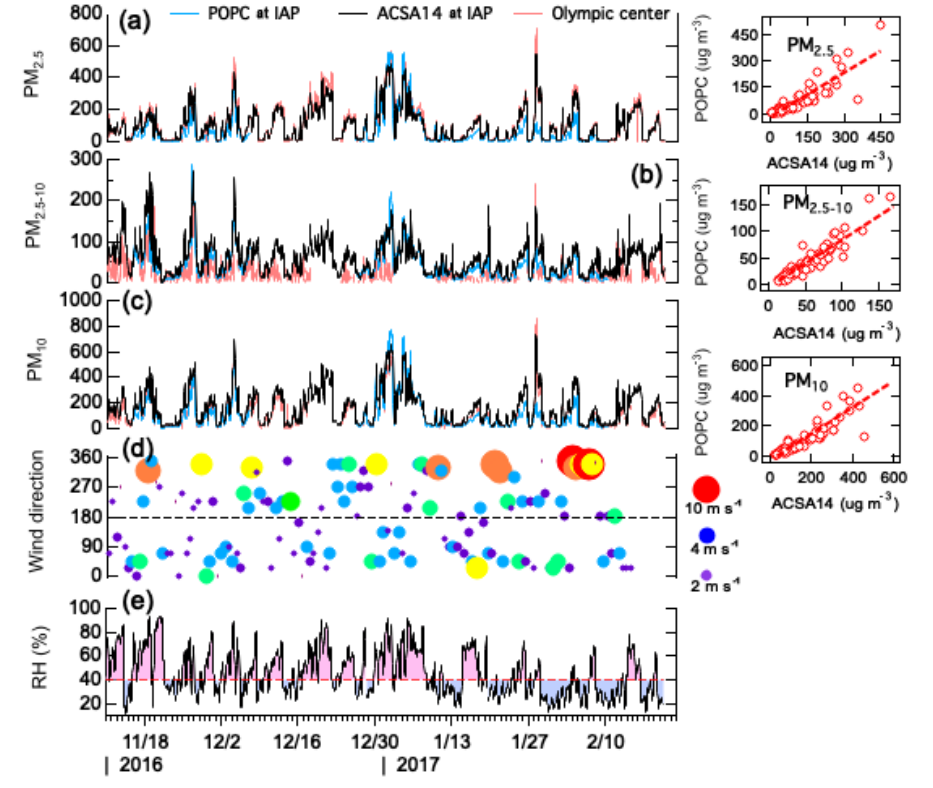
Figure 2. Temporal variations in mass concentration of PM 2 . 5 (a) , PM 2 . 5 − 10 (b) and PM 10 (c) measured by ACSA-14 and derived from POPC measurements, wind speed and direction (d) and relative humidity (RH) (e) at the observation site. The three scatter plots on the right indicate the linear relationship between ACSA14 and POPC, the correlations are Y POPC = − 6 . 8 + 0 . 89 × X ACSA14 ( r 2 = 0 . 86), Y POPC = 2 = 0 . 77) and Y 2 = 0 . 81) for PM − 19 . 5 + 0 . 84 × X = − 27 . 7 + 0 . 87 × X ACSA14 ( r POPC ACSA14 ( r 2 . 5 , PM 2 . 5 − 10 and PM 10 ,